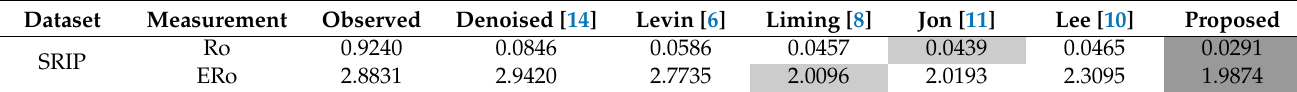
Table 3. Quantitative measurements of restored real infrared image qualities of non-blind deconvolu- tion algorithms by following two quality assessments: Ro and